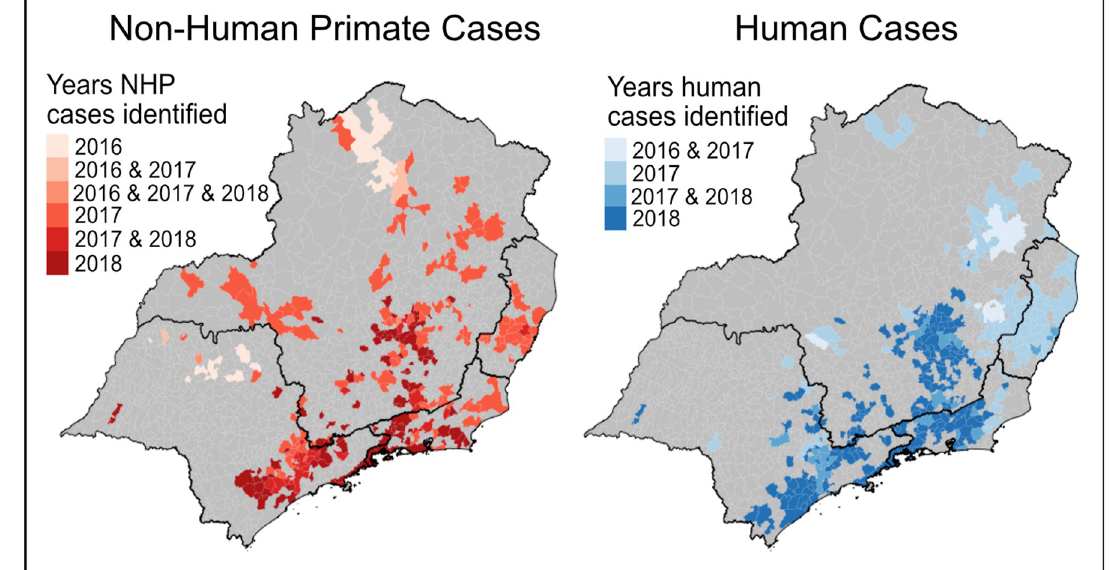
Fig 2. NHP & human yellow fever virus cases by year. Abbreviations: NHP = Non-human primate. NHP cases (left map) were identified in the rural, northern area of Minas Gerais starting in 2016 and continuing through the epidemic in 2017 and 2018. The earliest human cases (right map) identified during this outbreak also occurred in northern Minas Gerais in 2016 and 2017. As the epidemic progressed through 2017 and 2018, both NHP and human cases spread south into the urban centers of Rio de Janeiro and S ã o Paulo. YFV case data received from SINAN [24]. Municipality boundaries available from Instituto Brasileiro de Geografia e Estatistica (IBGE) (https://portaldemapas.ibge.gov.br/portal.php#homepage) [26].